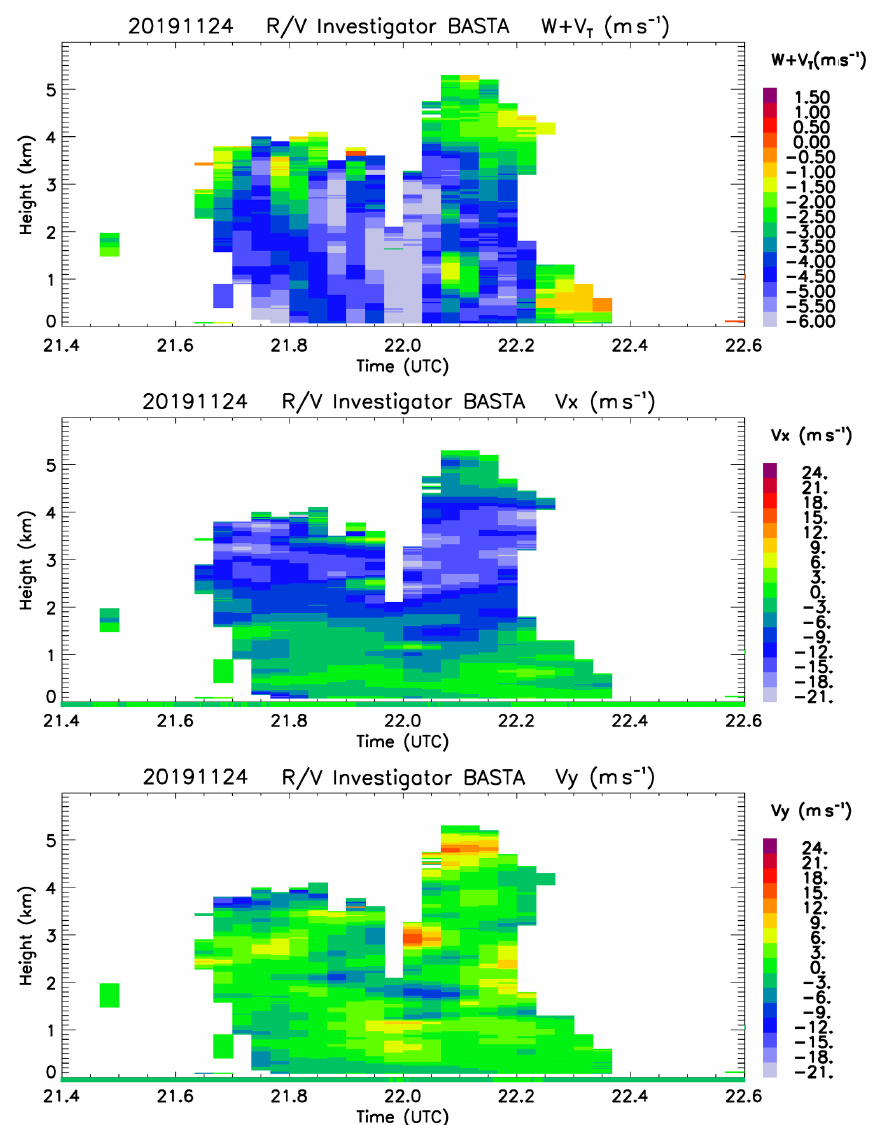
Figure 4. Same as Fig. 2 but for the cumulus congestus case on 24 November 2019 and a maximum display height of